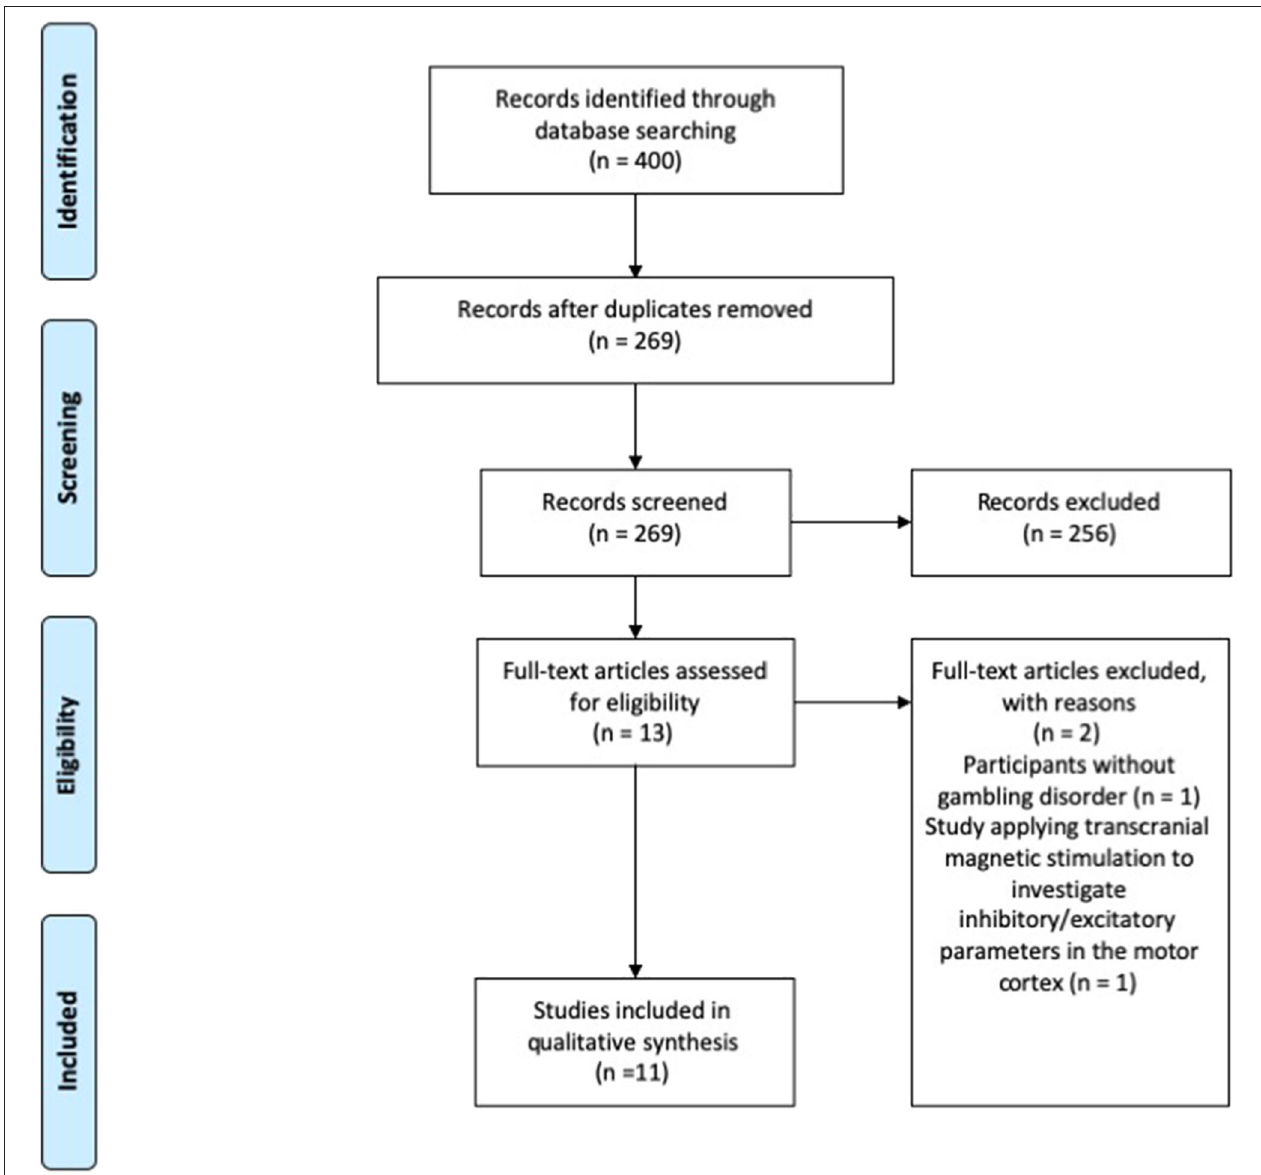
FIGURE 1 | PRISMA diagram of the study (www.prisma-statement.org).